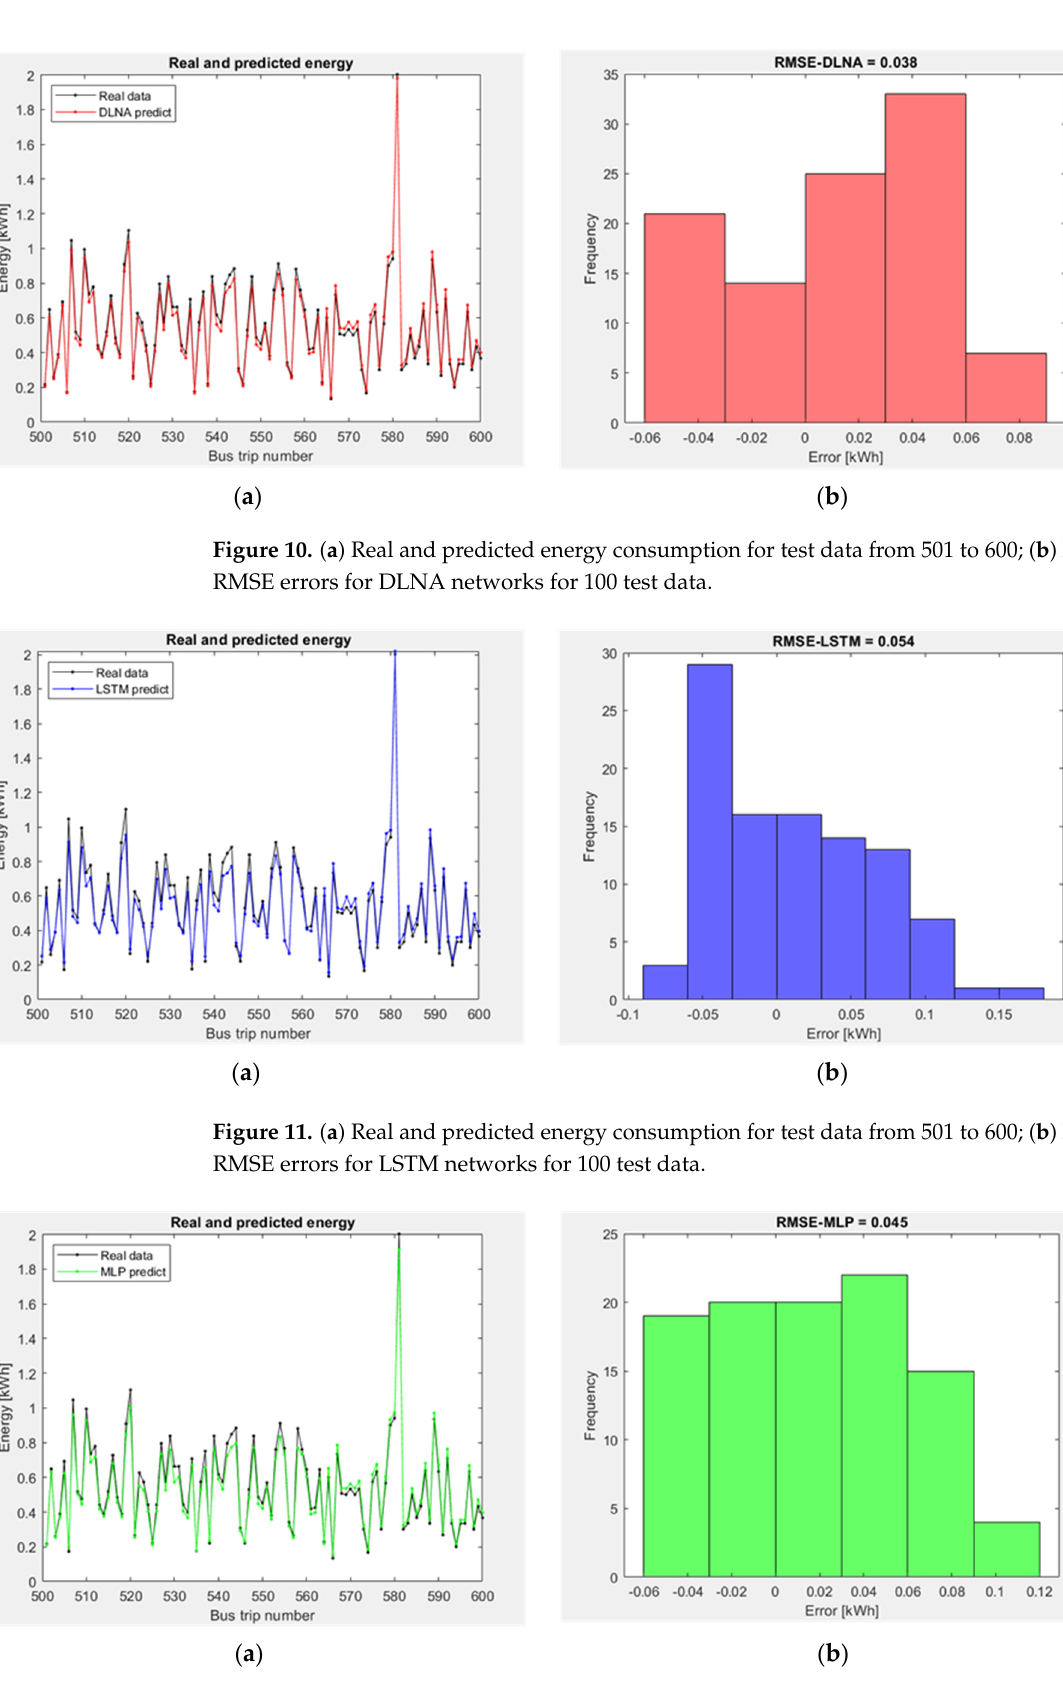
Figure 12 . ( a ) Real and predicted energy consumption for test data from 501 to 600; ( b ) Histogram for RMSE errors for MLP networks for 100 test data.